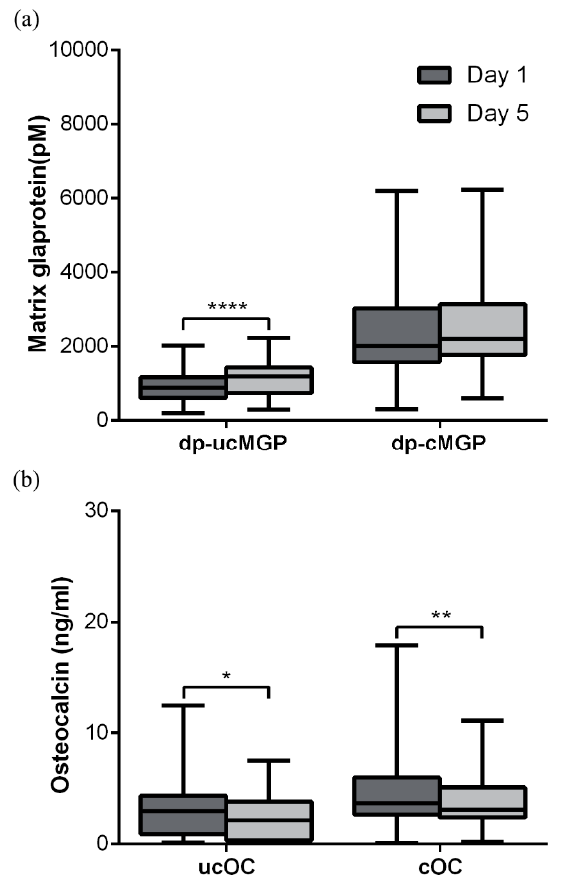
Figure 1. ( a , b ) Boxplot changes in matrix Gla protein (MGP) and Osteocalcin (OC), where dp-ucMGP = desphospho-uncarboxylated matrix Gla protein, and dp-cMGP = desphospho-carboxylated matrix Gla protein; and osteocalcin (OC), where ucOC = uncarboxylated osteocalcin, and cOC = carboxylated osteocalcin. Significance levels: * p < 0.05, ** p ≤ 0.01 and **** p ≤ 0.0001.